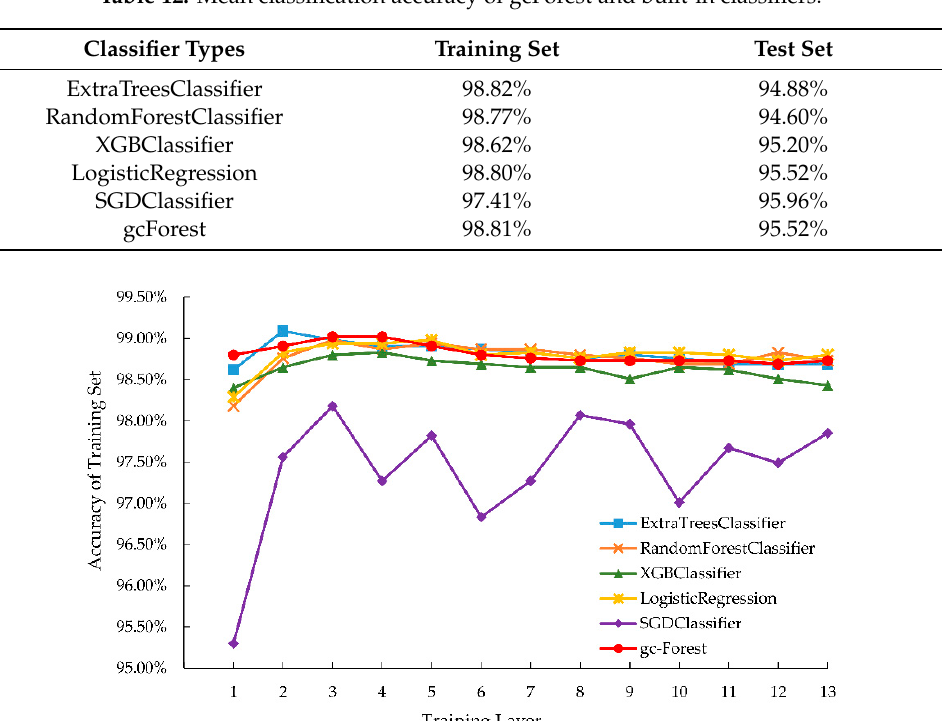
Table 12. Mean classification accuracy of gcForest and built-in classifiers.